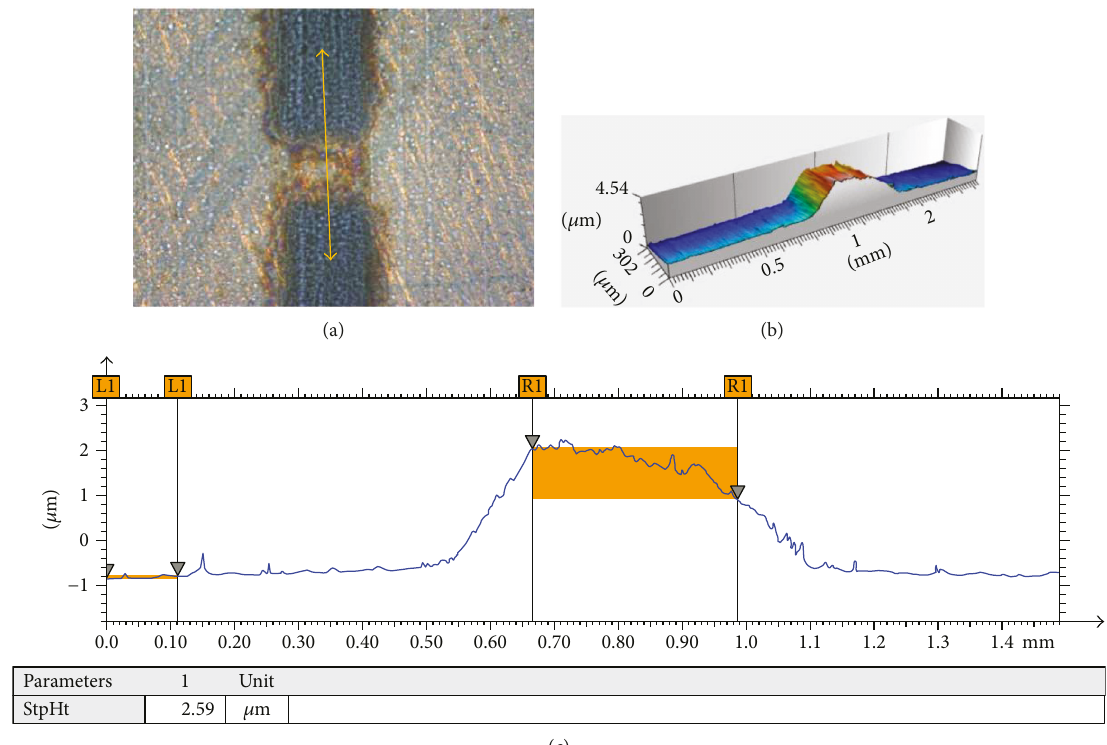
Figure 3: (a) First printed PEDOT layer on Kapton substrate. (b) APEX 3D thickness analysis. (c) Thickness measurement by KLA-Tencor.